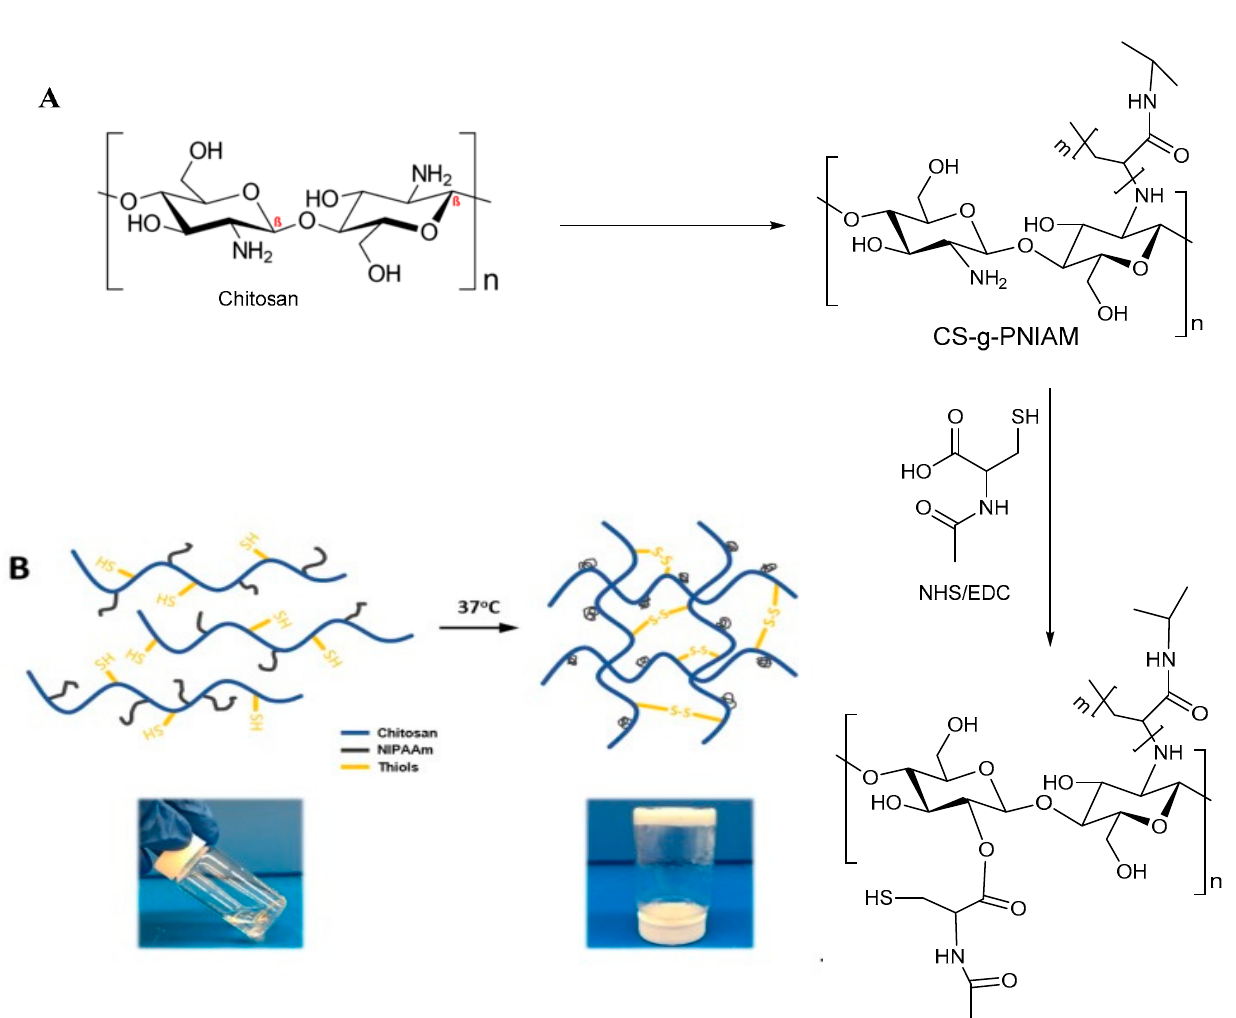
Figure 10. Formation of IHs via disulfide bonds between the free thiol containing polysaccharide polymers. ( A ) copolymerization of N-isopropylacrylamide with chitosan and thiol modification using carbodiimide ( B ) gelation mechanism; physical (helix-coil structure) and chemical cross-linking (disulfide bond formation) (adapted with permission from Wu et al., 2018)..